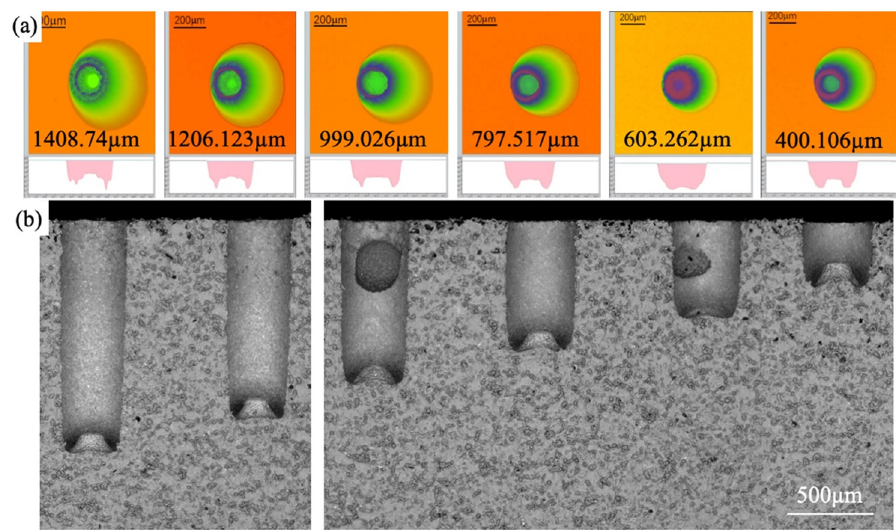
Figure 8: Blind holes processed by tungsten steel electrode: ( a ) the 3D morphology; ( b ) the SEM image ( frequency = 130 kHz, pulse width =